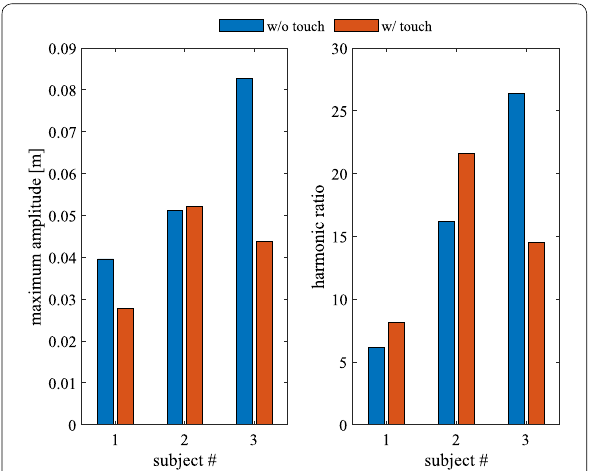
Fig. 14 Maximum amplitude and harmonic ratios of the postural angle projected on the coronal plane of each subject. The left figure shows the maximum amplitudes of the postural angle projected on the coronal plane at the frequencies of the trials, and the right figure shows the harmonic ratios of them. The maximum amplitudes of the two subjects slightly decreased. On the other hand, the harmonic ratios of two of the subjects increased